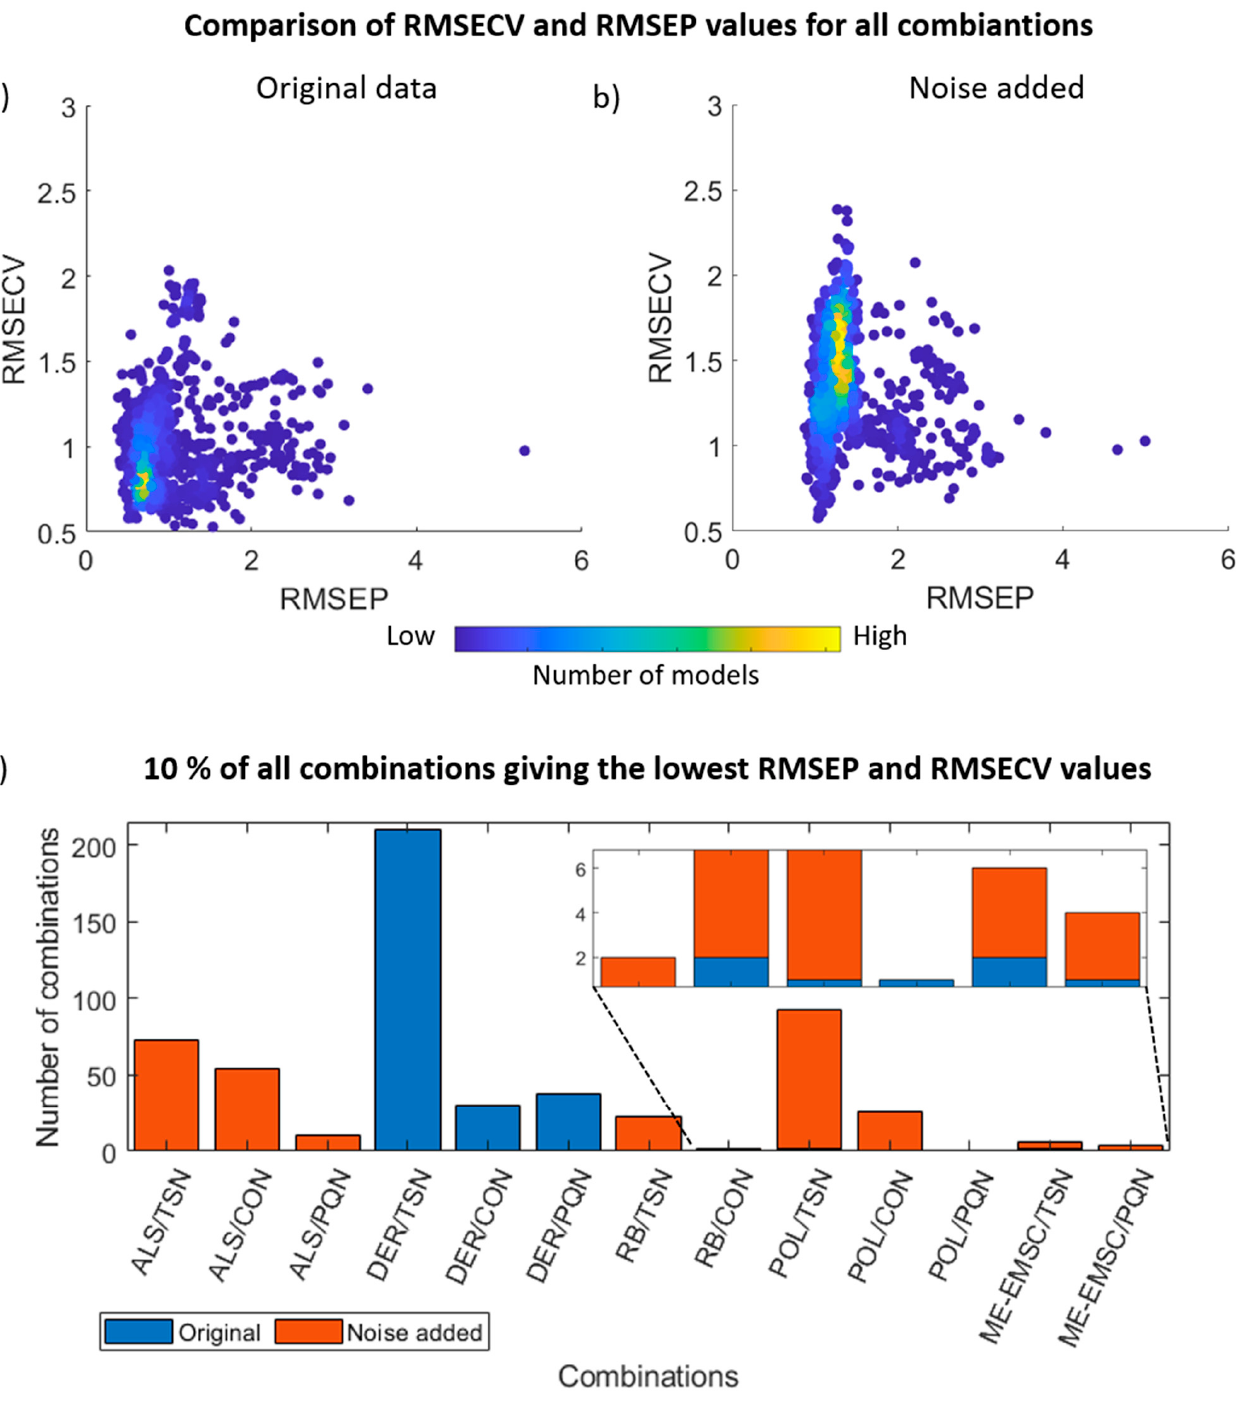
Figure 5. Comparison of RMSECV and RMSEP values for: ( a ) original data and ( b ) noise added data. Each dot on the plot presents a value for one combination of preprocessing methods. ( c ) Histogram of 10% of all combinations giving the lowest RMSECV and RSEMP for the original and noise added data.